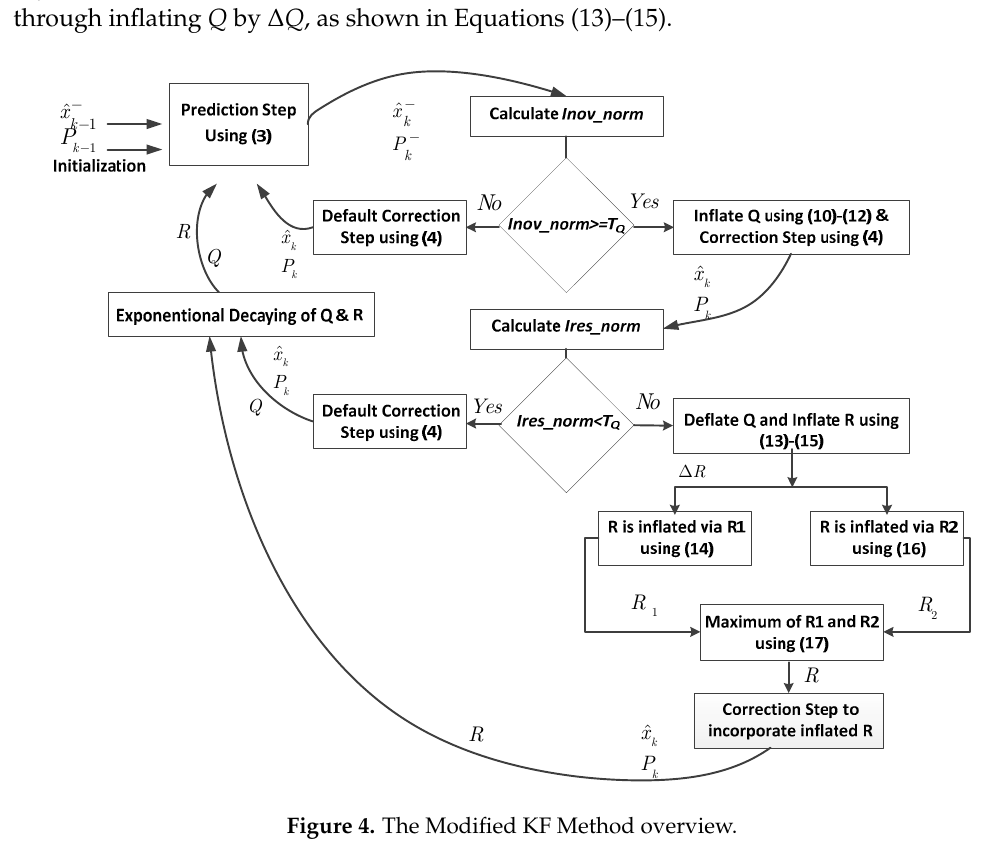
Figure 4. The Modified KF Method overview.